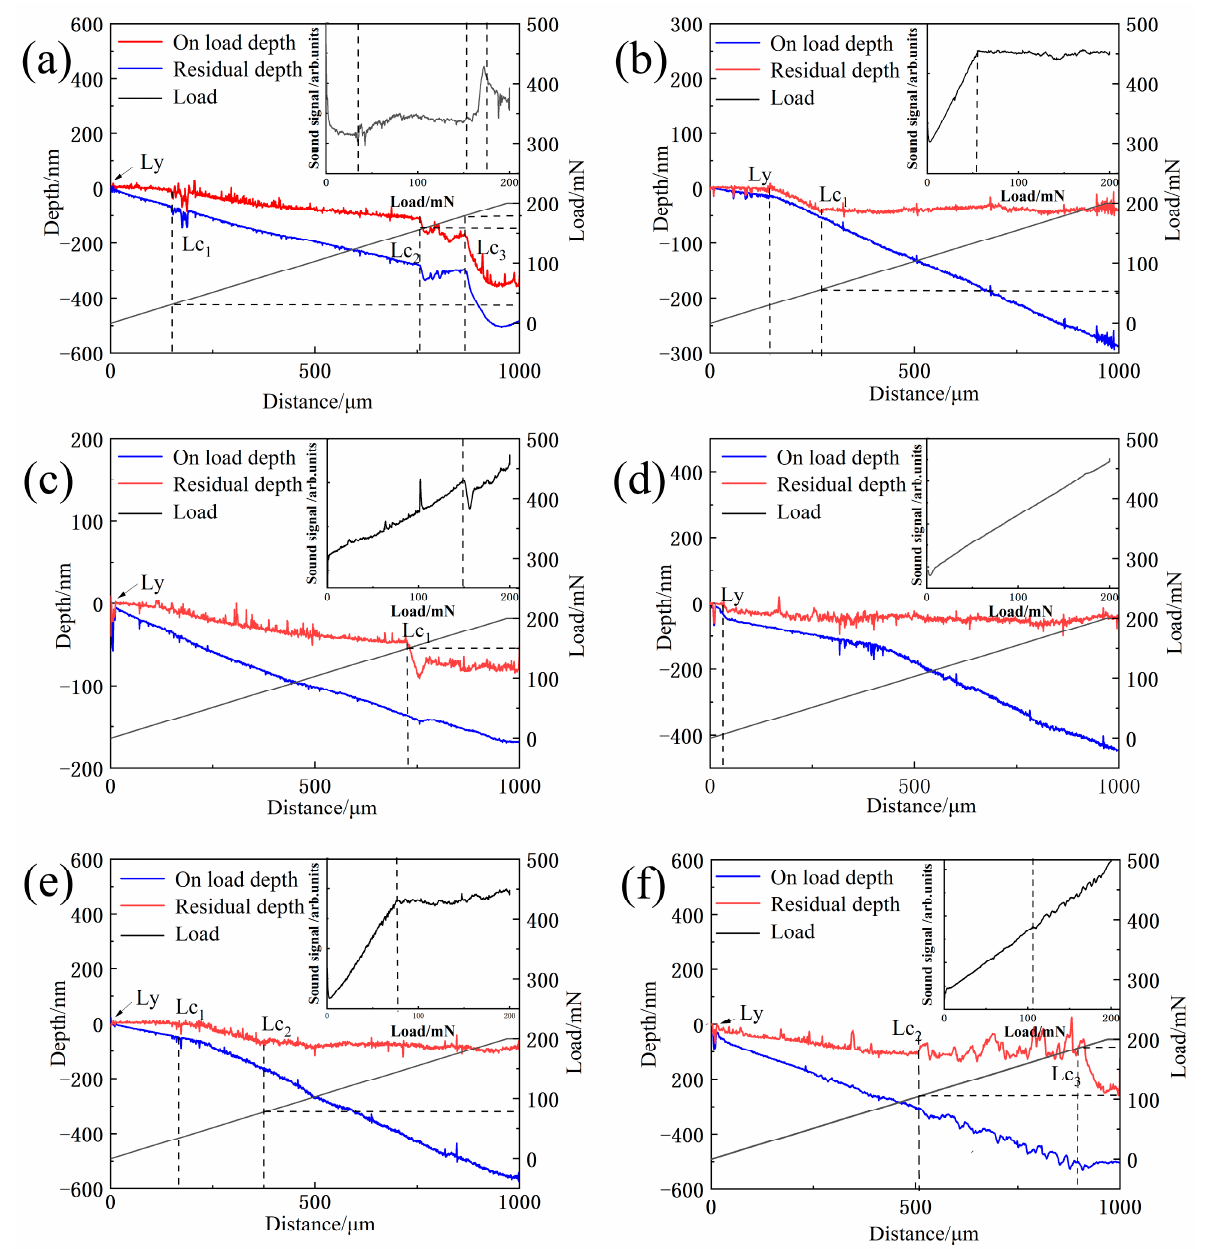
Figure 7. Variation curves of the load, scratch depth, residual depth, and acoustic signal versus scratch distance of the Si-B-C-N/DLC gradient films. ( a ) Sample 1, ( b ) Sample 2, ( c ) Sample 3, ( d ) Sample 4, ( e ) Sample 5, ( f ) Sample 6. Lc : critical load, Ly : plastic deformation of the film begins to occur, Lc 1 : a few cracks begin to sprout on the film surface, Lc 2 : scratch edges appear broken, Lc 3 : film is mostly peeled off, Rd : scratch depth. The dashed lines’ positions in the figure represent the corresponding scratch distance, load, and acoustic noise signals at the critical state. Table 2. Critical load and residual depth of the Si-B-C-N/DLC films.